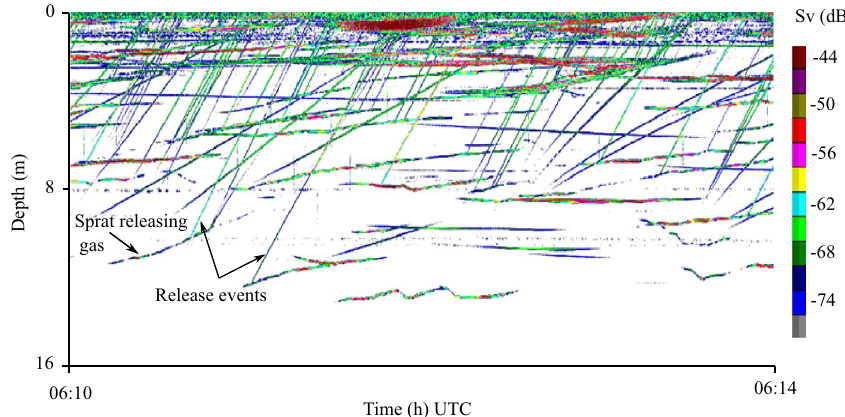
Figure 4. Echogram showing sprat releasing gas, with every oblique line representing one release event and lines with a different angle to the release events representing swimming sprat. Colors represent the volume- backscatter coefficient